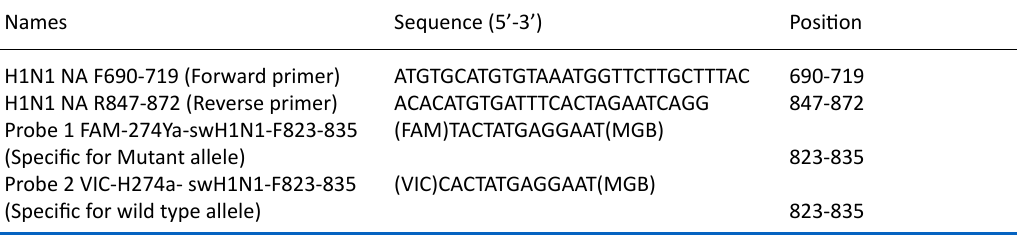
Table 1. Primers and probe sequences for allelic discrimination PCR